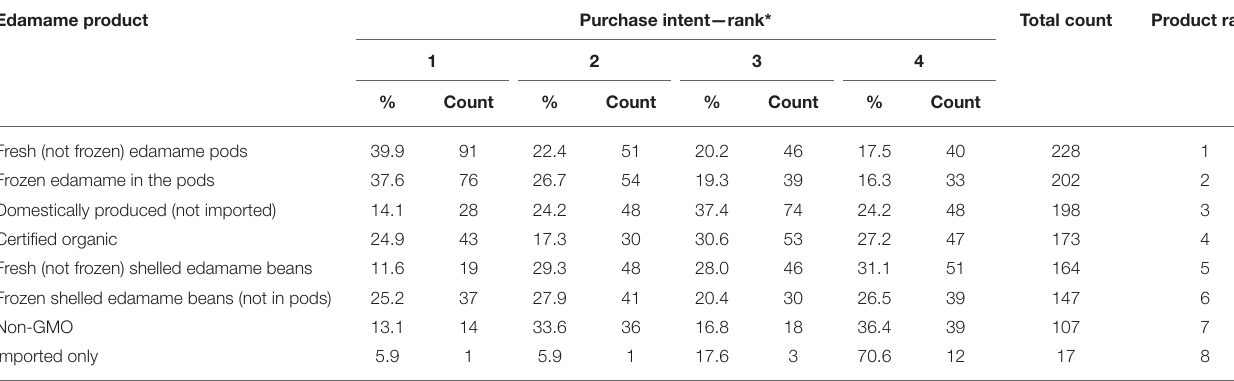
TABLE 6 | Rank of edamame products most likely to be purchased by consumers in the